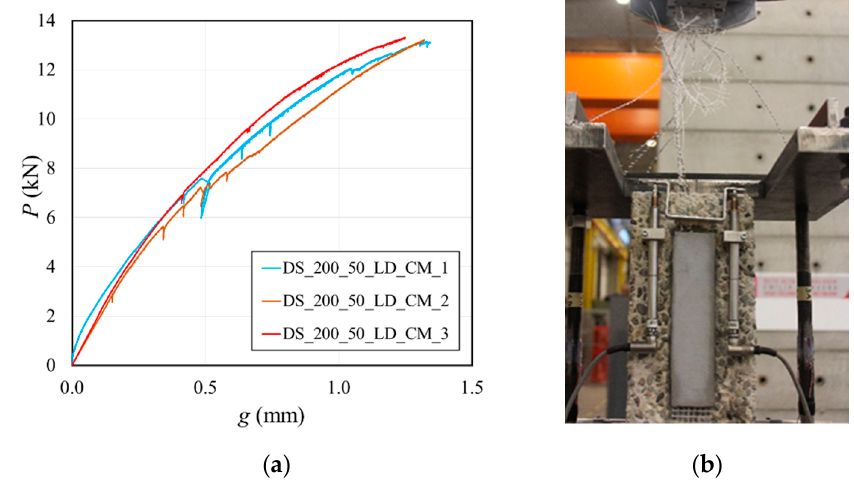
Figure 9. ( a ) Load response of SRG-concrete joints and ( b ) photo of failure mode due to the rupture of steel fibers [43].